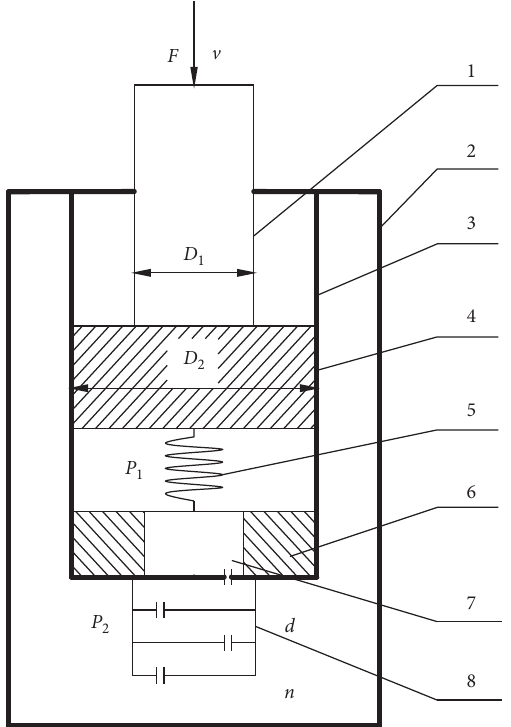
Figure 4: Simplified oil circuit diagram of the magnetoelectric hybrid suspension hydraulic damper. 1, piston rod; 2, outer cyl- inder; 3, inner cylinder; 4, electromagnet; 5, spring; 6, permanent magnets; 7, magnetorheological hydraulic oil; 8, damping